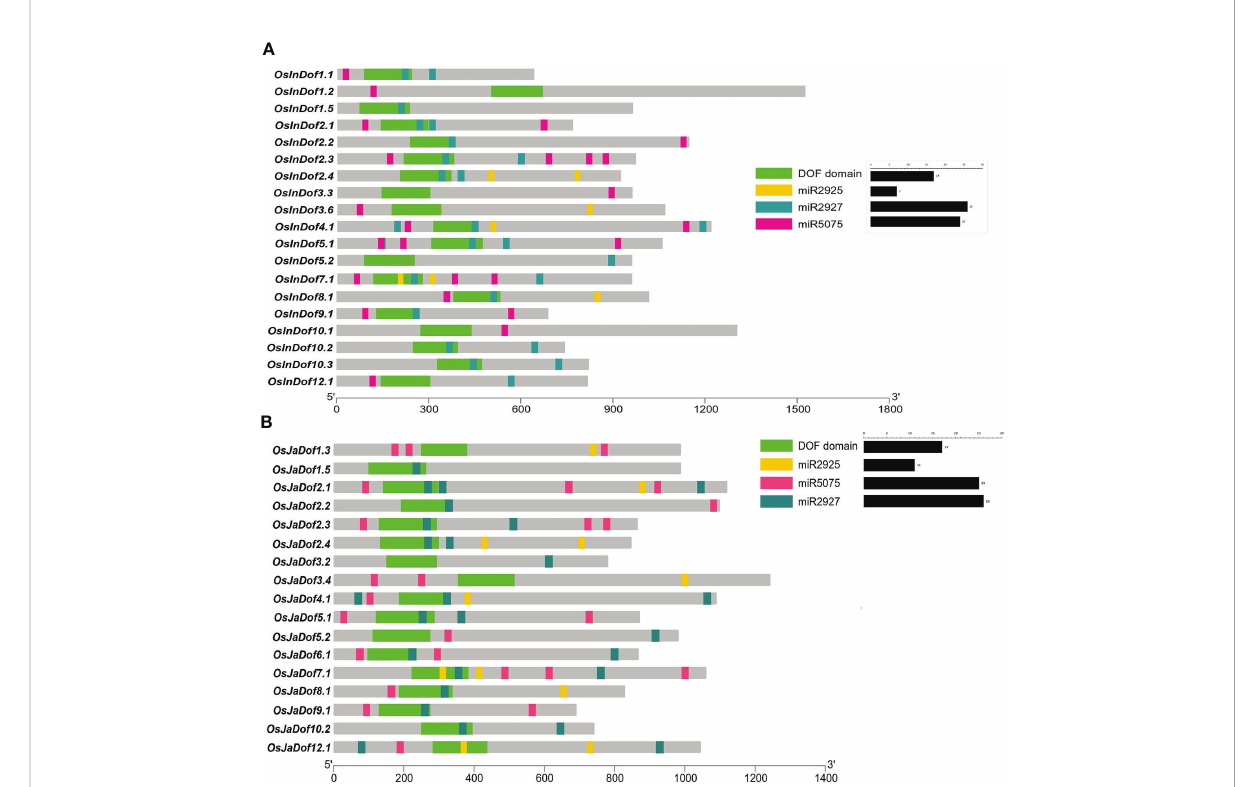
FIGURE 5 miRNA ’ s potentially targeting (A) indica and (B) japonica Dof genes. Previously reported information related to rice miRNAs and their potential targets was retrieved from the psRNA Target Server (Dai et al., 2018) and target sites were mapped onto the transcripts of Dof genes with TBtools (Chen et al.,